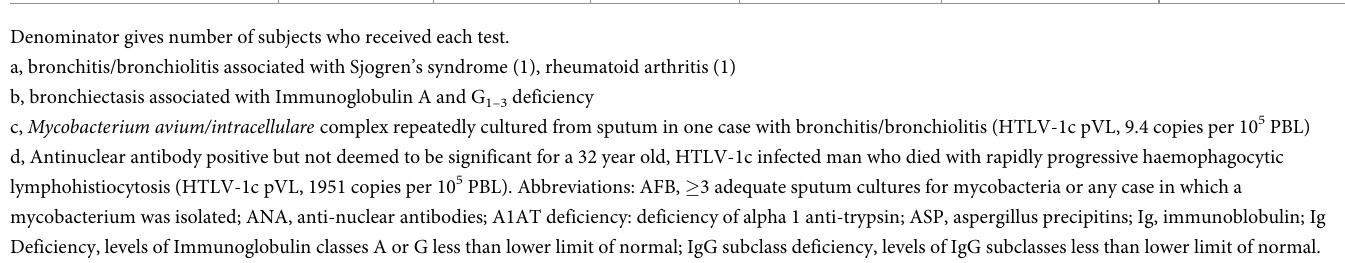
Mortality During 2140 person-years of follow-up, 155 deaths were recorded (HTLV-1 uninfected, 85; HTLV-1 infected, 70). Non-bronchiectasis causes of death were infections (37)(lower Table 2. Investigations for causes of radiologically defined airways inflammation according to HTLV-1 serostatus. AFB ANA ASP Ig IgG subclass A1AT Deficiency Deficiency Deficiency 0/39 2/48 a 0/47 1/48 b 1/44 b 0/42 1/60 c 1/59 d 0/53 0/53 0/49